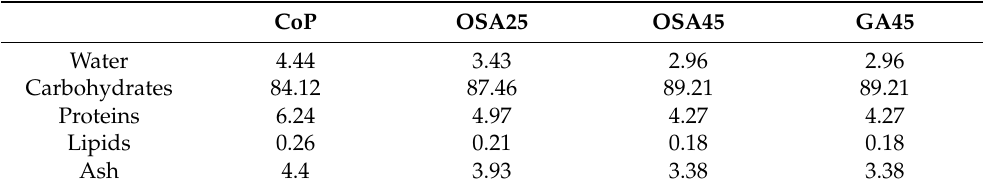
Table 6. Composition (g/100 g) of the different formulations of the freeze-dried orange juice co- product (codes according to Table